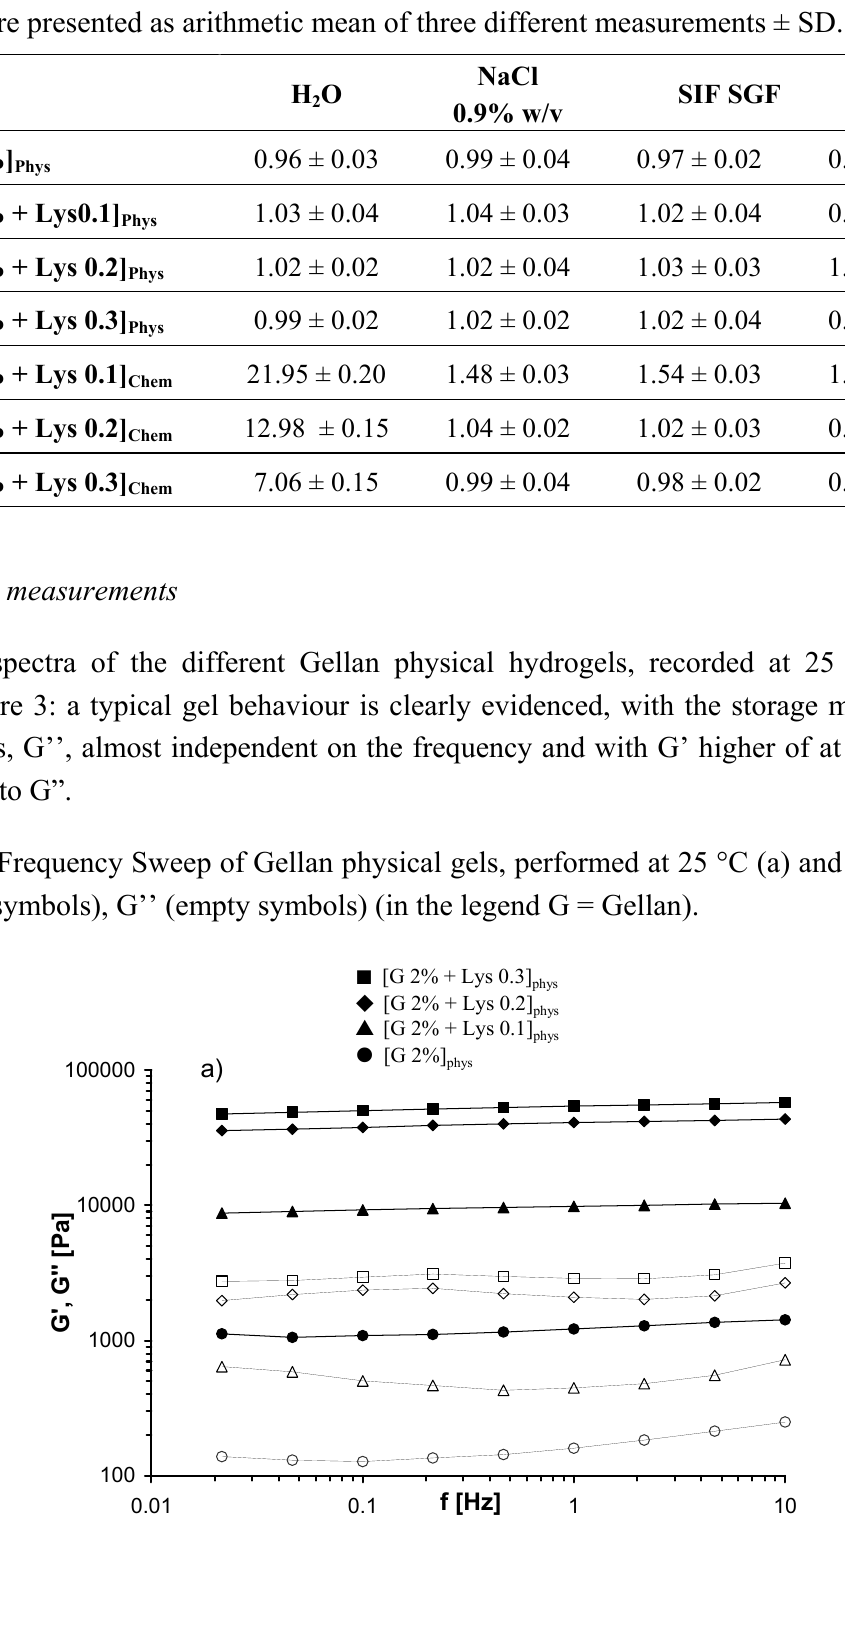
Table 1. w R ratio (w eq /w 0 ) for the different hydrogels, swollen in different media at 37 °C. The data are presented as arithmetic mean of three different measurements ± SD.